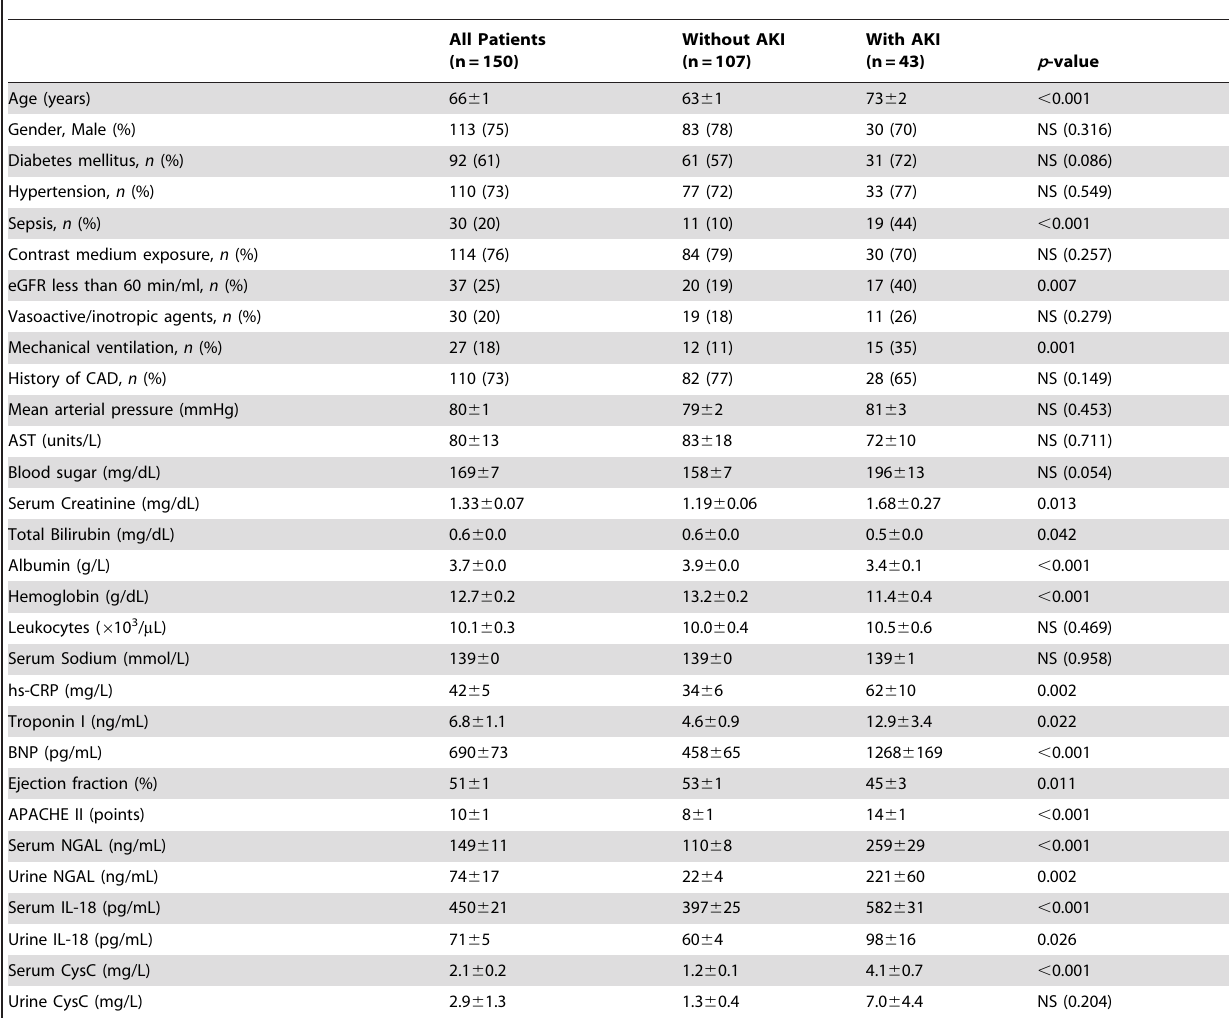
Table 1. Patient demographic data and clinical characteristics on the first of CCU admission according to with/without AKI.